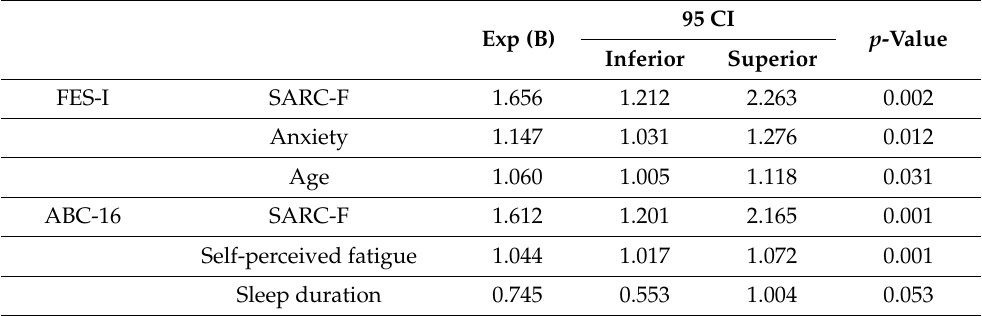
Table 4. Multivariate logistic regression analyses for risk of falling regarding FES-I and ABC-16